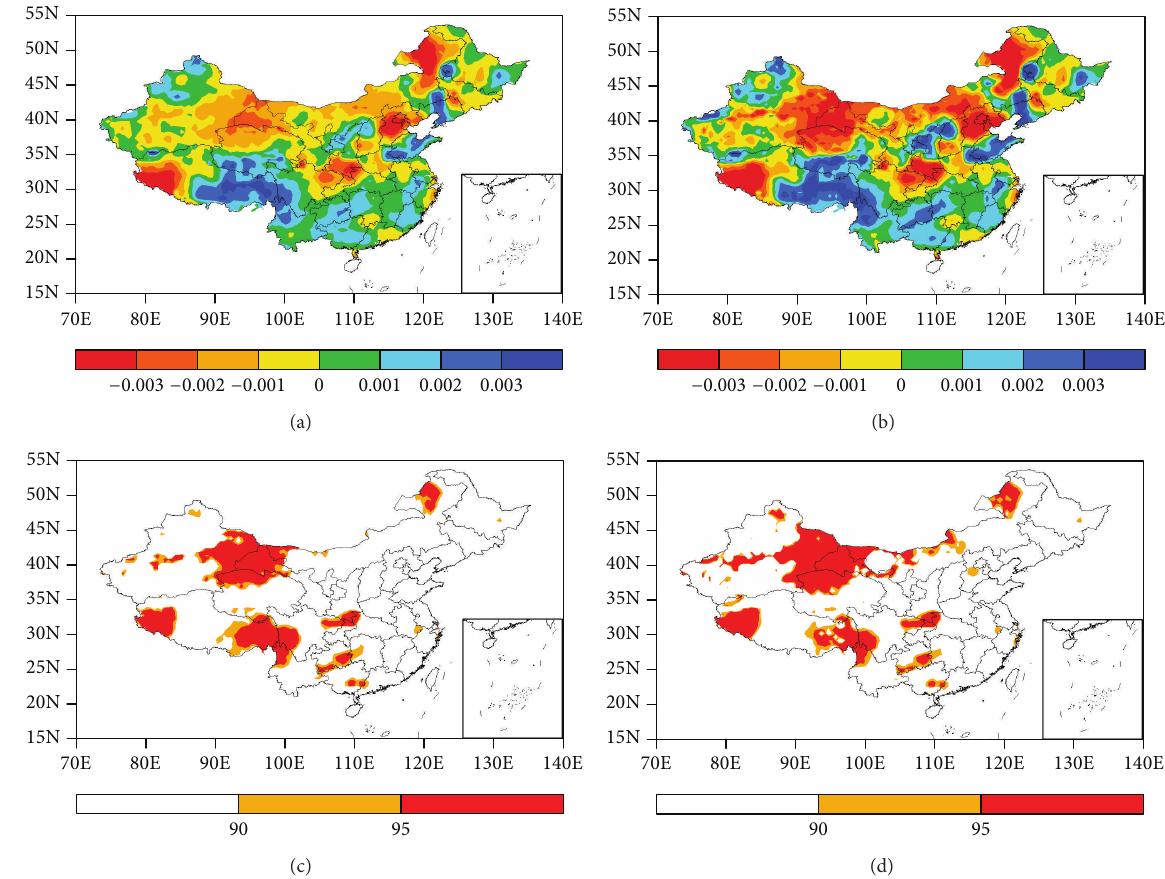
Figure 6: Spatial distribution of simulated mean SM variation linear trends for the summer (June–August) of 1961–2010 (unit: (m 3 /m 3